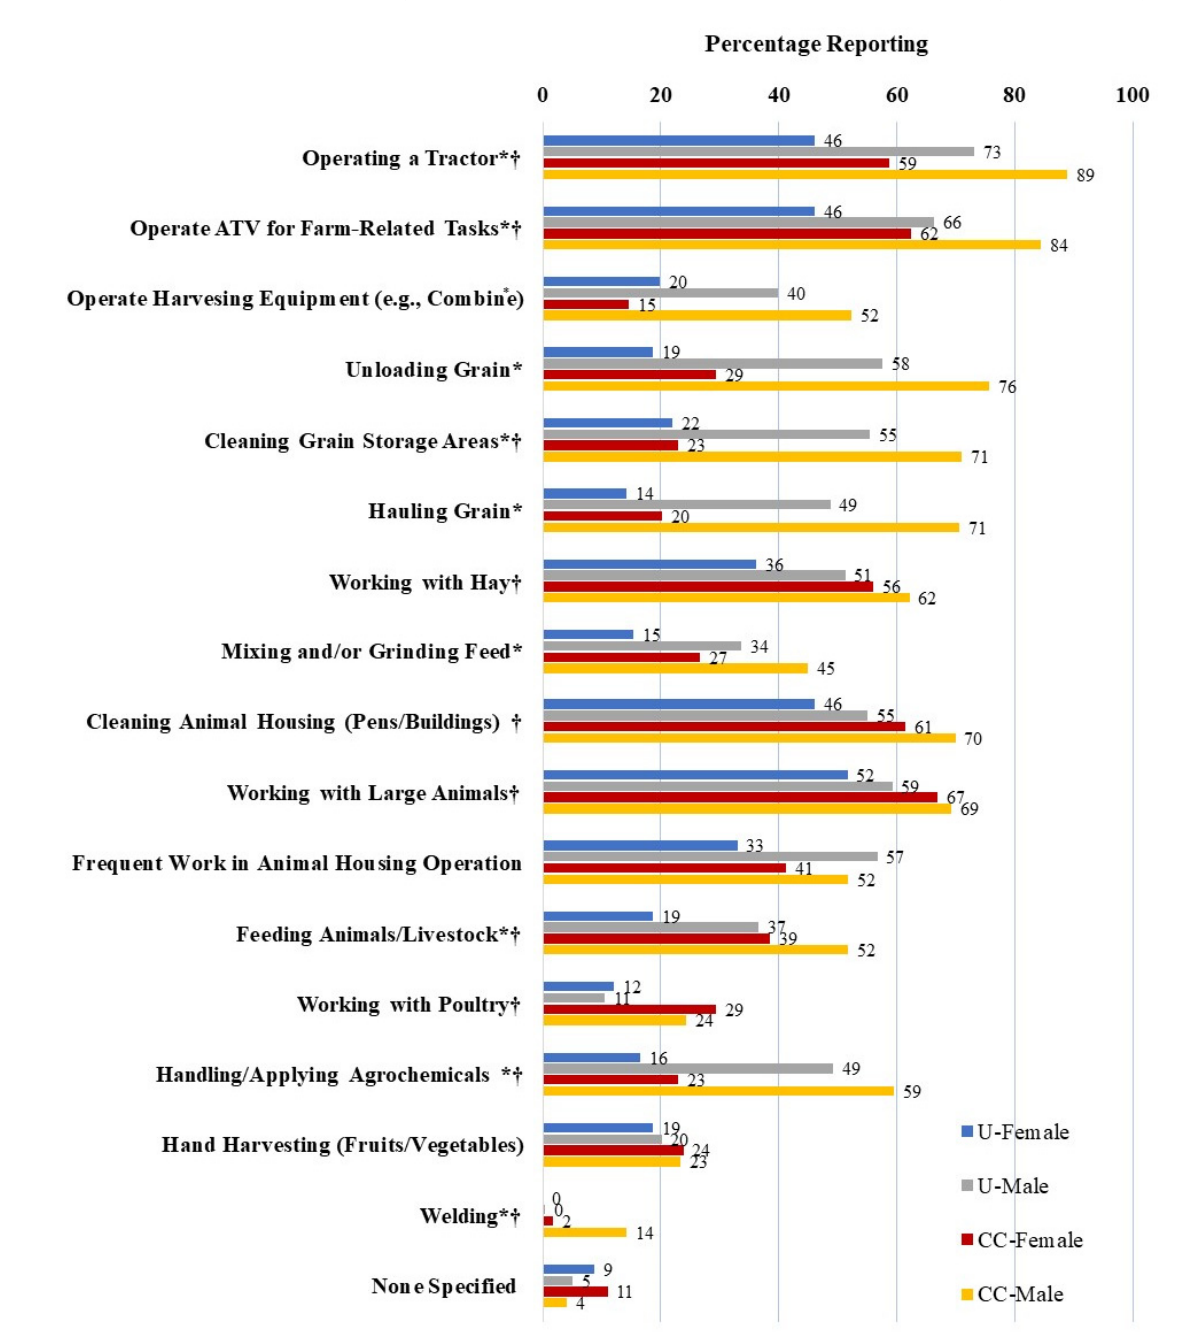
Figure 1. Proportion of participants reporting farm tasks performed in the previous 12 months. Note: Female = University female; U-Male = University male; CC-Female = Community College Female; CC-Male = Community College Male. * Indicates differences between male and female responses, using a 2 proportions Z-test ( p ≤ 0.05); † Indicates differences between university and community college responses, using a 2 proportions Z-test ( p ≤ 0.05).